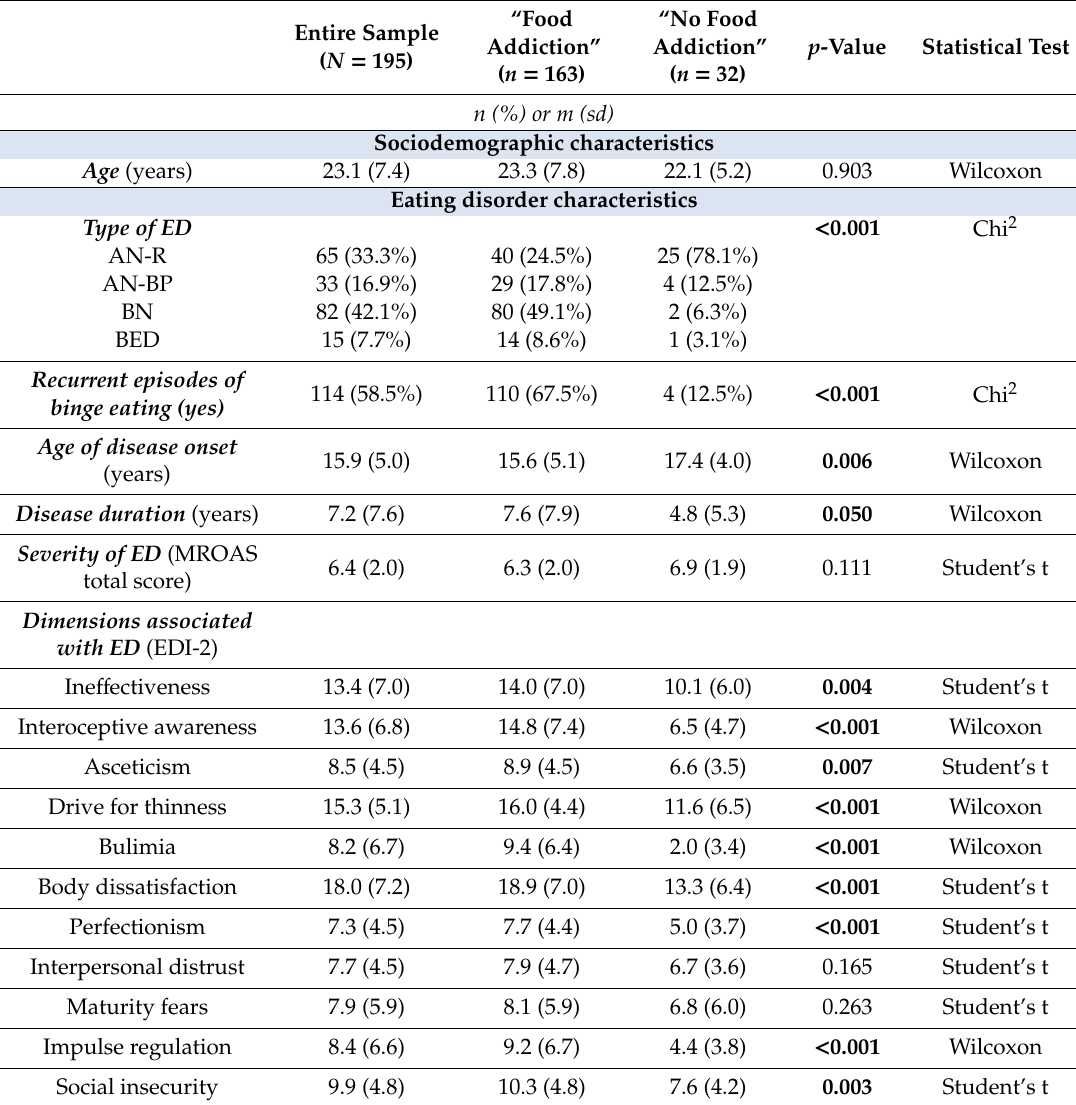
Table 2. Description of the sample and comparison of the patients with “Food Addiction” or “No Food Addiction” ( n = 195)—Sociodemographic and Eating Disorder